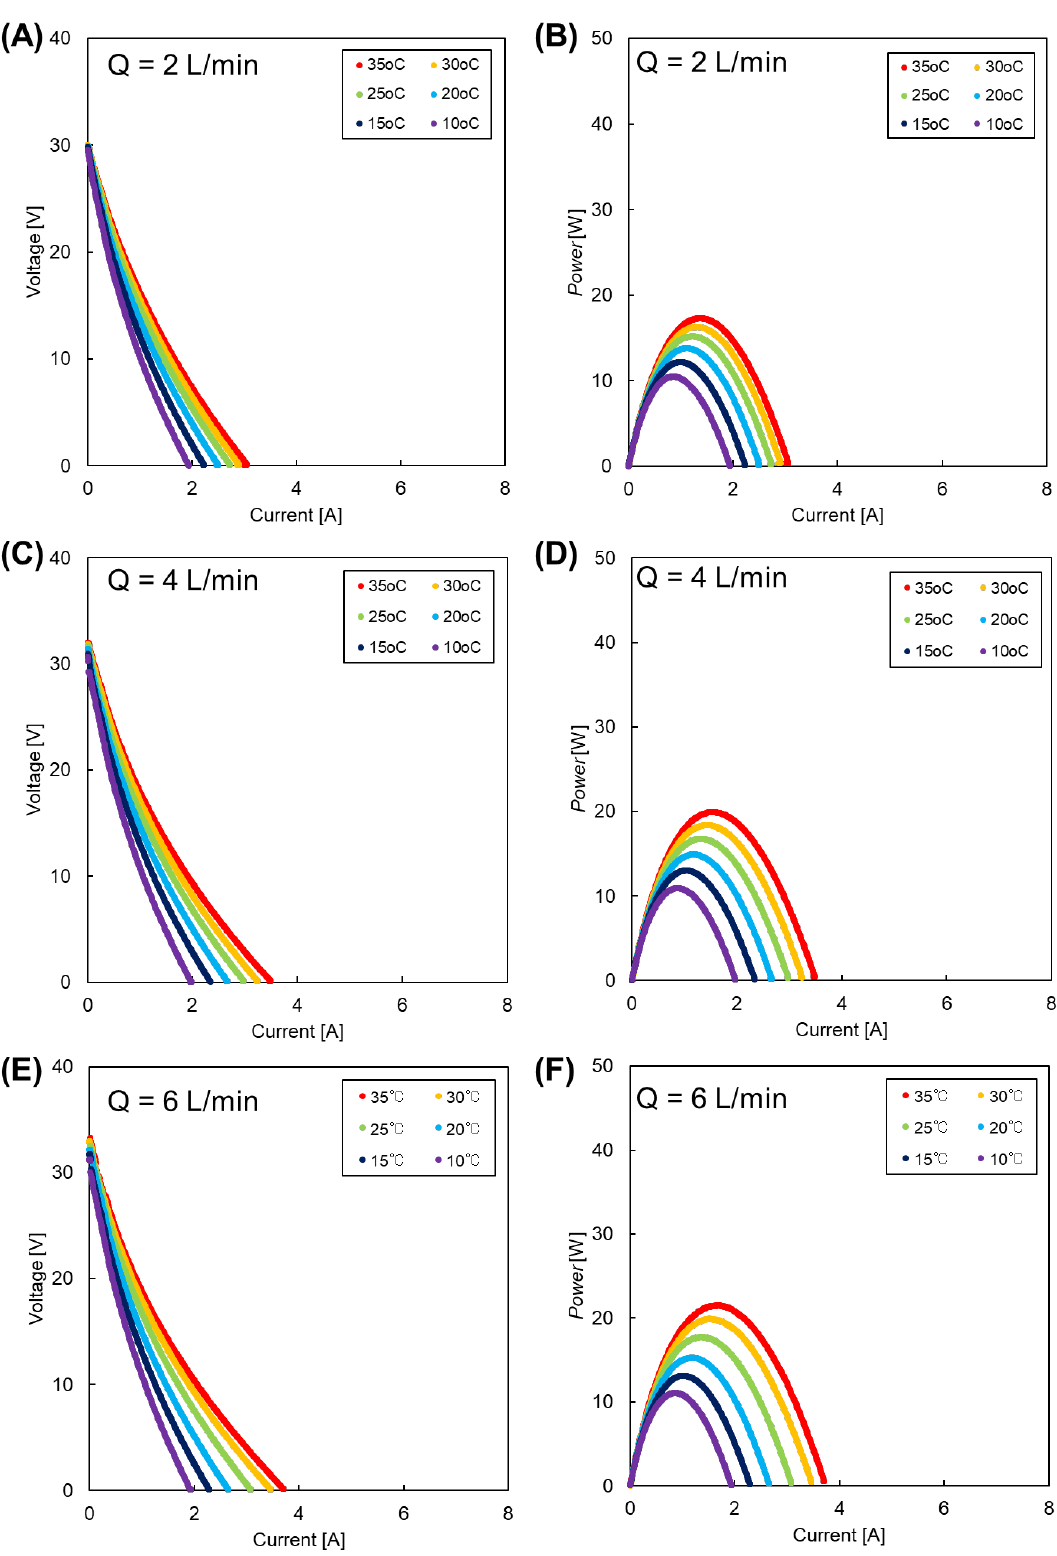
Figure A2. ( A , C , E ) current-voltage (I-V) and ( B , D , F ) current-power (I-P) relationships of the RED stack having the intermediate distance of 600 µm at 10–35 °C with different flow rate, Q.